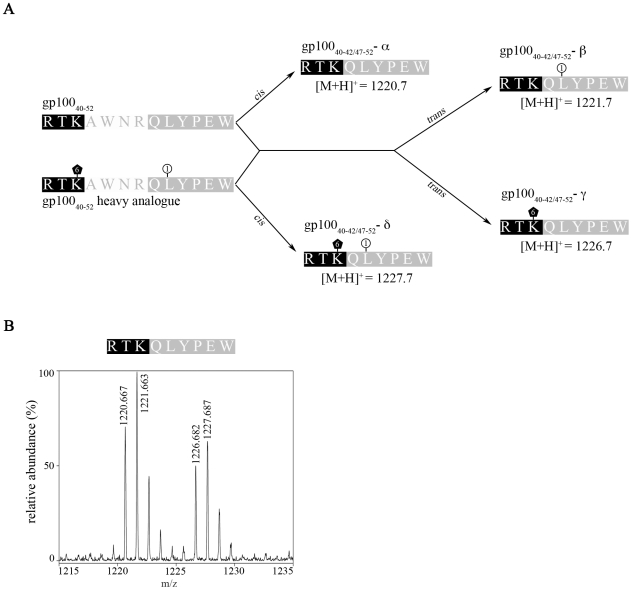
Generation of PSP by proteasomal trans splicing.(A) To demonstrate the generation of a PSPtrans by the binding of two fragments originated from two distinct molecules of substrate, 5 nmol gp10040–52 and its heavy analogue with amino acids 13C6-Lys and 15N-Leu (RTK+6AWNRQL+1YPEW) were digested together for 36 hours by 1.5 µg LcL 20S proteasomes in 100 µl buffer. Theoretically four different PSP could be generated from the cis or trans ligation of the proteasomal fragments [RTK] and [QLYPEW] with sequences [RTK][QLYPEW]: gp10040–42/47–52-α, [M+H]+  = 1220.7; gp10040–42/47–52-β, [M+H]+  = 1221.7; gp10040–42/47–52-γ, [M+H]+  = 1226.7; gp10040–42/47–52-δ, [M+H]+  = 1227.7. (B) LC-MALDI-TOF/TOF-MS spectra at RT  = 41.3 min show peaks which can be assigned to all four possible PSP of gp10040–42/47–52 (for MS/MS spectra see Figure S1).